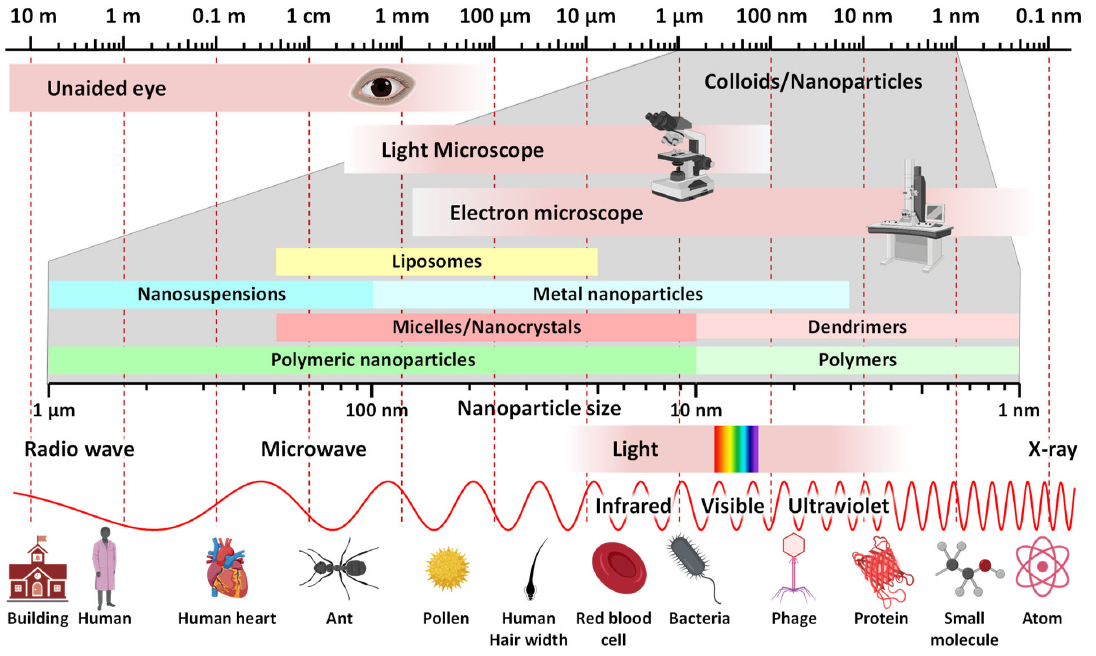
Figure 8. Nanoparticles/colloids are very small formations with a size between 1 nm (0.000001 mm) and 1 μ m (0.001 mm). They cannot be seen with the naked eye nor can they be separated by the filtration through ordinary filter paper. Relatively large nanoparticles can be seen with a light microscope, while an electron microscope easily distinguishes nanoparticles of any dimensions. The size of nanoparticles is comparable to the wavelength of visible and ultraviolet light as well as the longest X-rays. They are significantly smaller than human cells and have a size similar to bacteria, phages, viruses and proteins. The size of nanoparticles that are used for the delivery of drugs and nucleic acids usually does not exceed 500 nm.